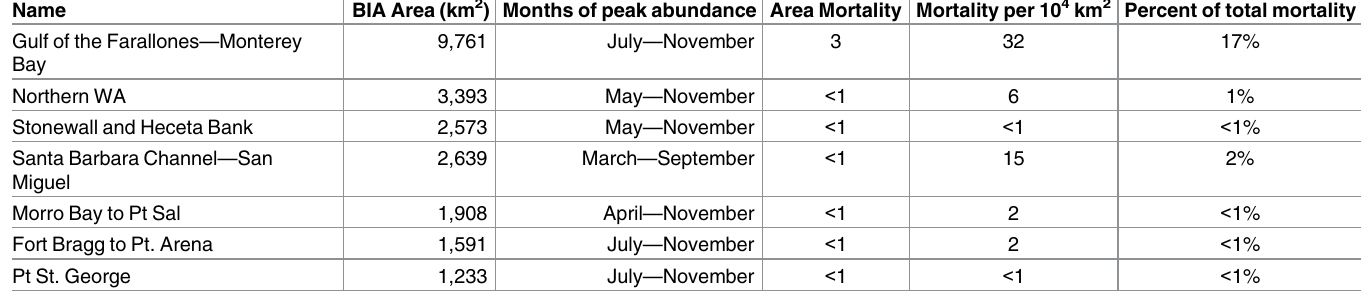
Table 5. Statistics of humpback whale strike mortality within the Biologically Important Areas(BIAs) defined in Calambokidis et al. 2015. Total mortality, mortality per 100,000km 2 and percent of total study area mortality are reportedfor each BIA. Name